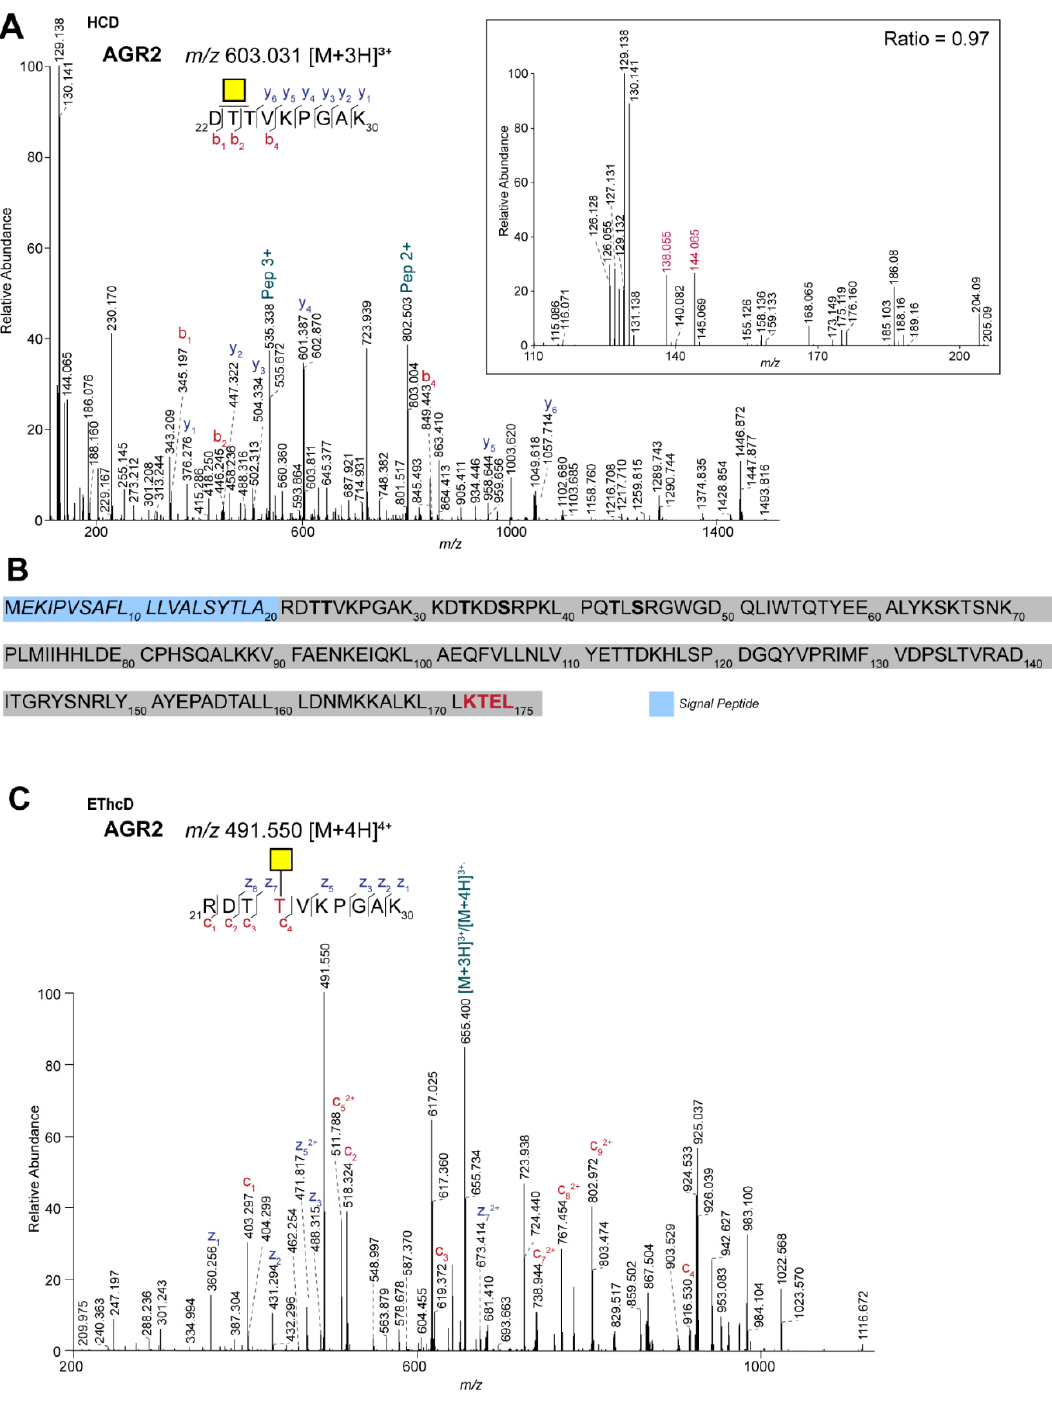
Figure 4. Site-specific identification of O- GalNAcylation of anterior gradient protein 2 (AGR2) in CRC cell lines. ( A ) HCD spectrum of the AGR2 TMT-labeled tryptic peptide DTTVKPGAK carrying a Tn antigen. The insert shows the TMT-reporter (9-plex), oxonium ions and ratio of m / z 144.066/138.055. The oxonium ions at m / z 138.055 and 144.066 used for the ratio are shown in red. Samples were labeled as follows: HT29: 126, 127N,127C; HCT116: 128N, 128 C, 129N; LS174T: 129C, 130N, 130C. Of note, m / z 126.055 represents the oxonium ion [HexNAc-C 2 H 6 O 3 ] + .Yellow square: GalNAc; Pep: peptide. ( B ) AGR2 protein sequence. The signal peptide is highlighted in blue and italic. In bold, predicted glycosylation sites are highlighted [25]. In red, the ER retention signal KTEL is indicated. ( C ) EThCD spectrum of the O- GalNAcylated TMT-labeled tryptic peptide RDTTVKPGAK from AGR2.